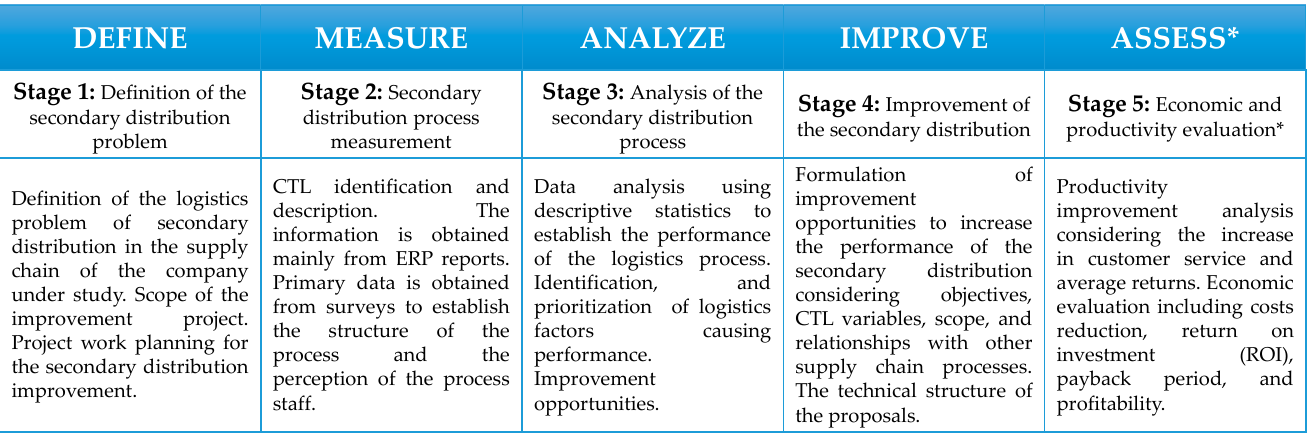
Figure 1. Stages of the methodological proposal.